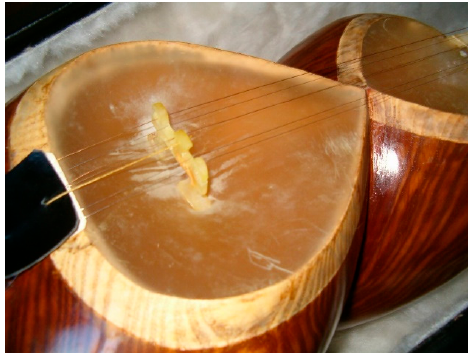
Figure 1. The Persian thar analyzed in this research in its original case.